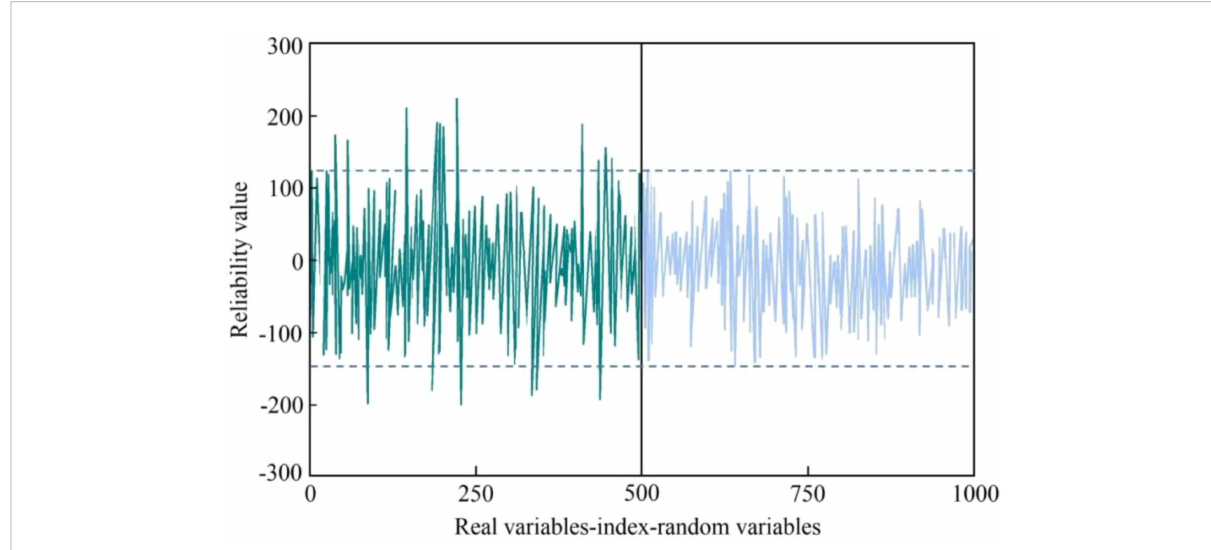
FIGURE 6 The UVE feature frequency point screening